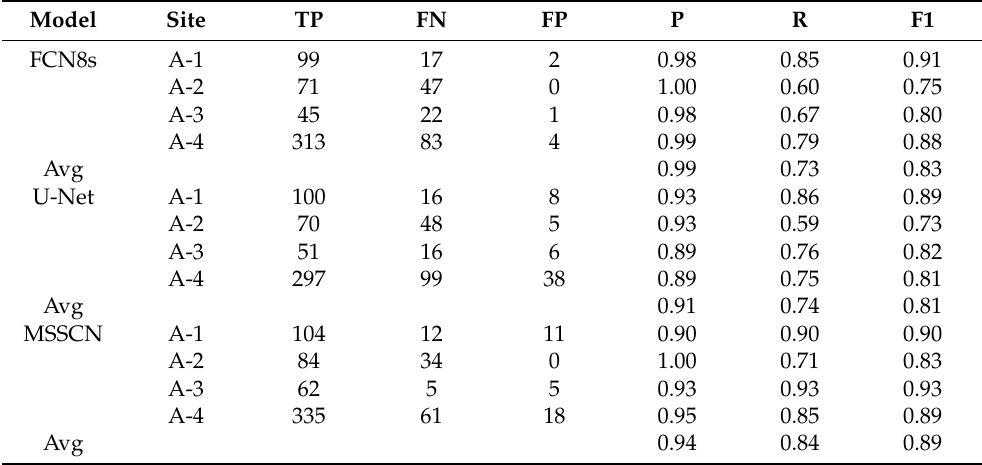
Table 4. The comparison of the proposed approach with benchmark approaches in different